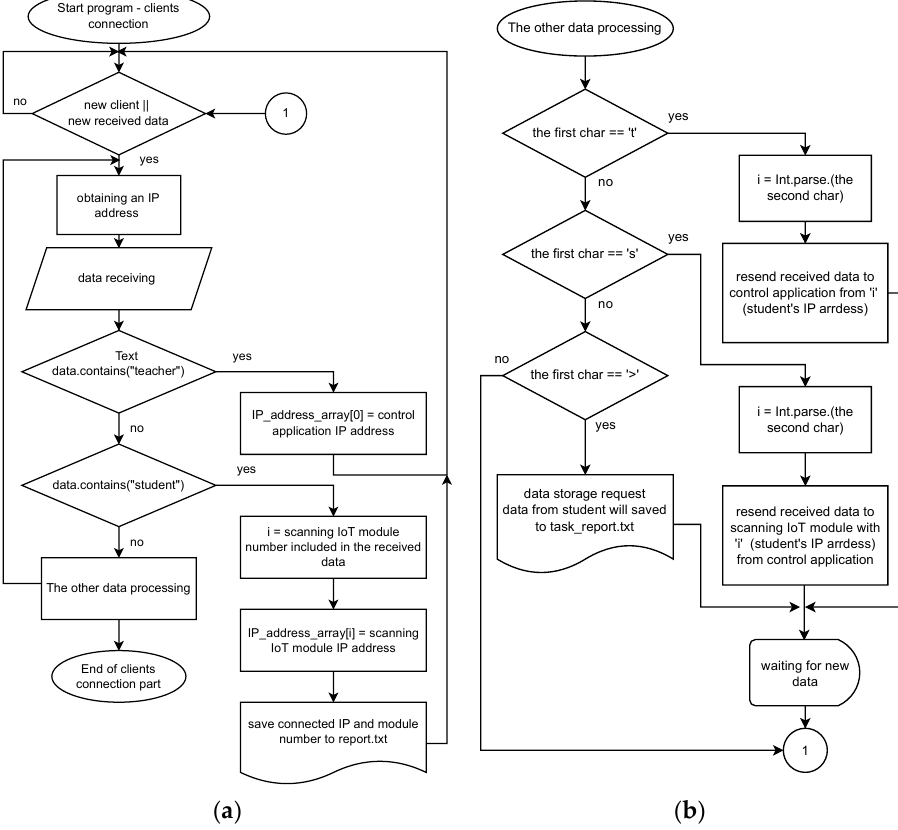
Figure 4. The shown flowchart describes the server program operations from the start of the server up to received data processing. The first flowchart ( a ) describes how clients connect to the server and save the data to a text file. The second flowchart marked as ( b ) is part of the first flowchart where the block “The other data processing” is extended and described.